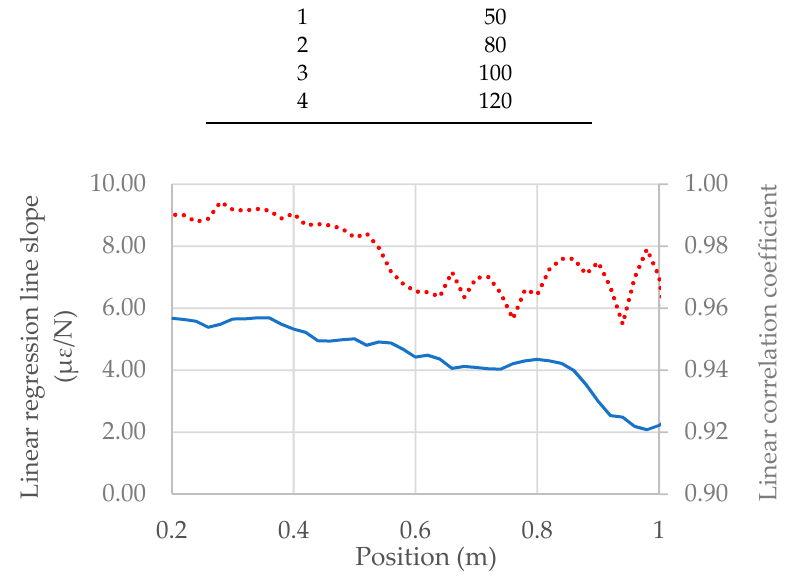
Figure 11. Linear regression slope and linear correlation coefficient obtained along the OF cable integrated in the DTWM.